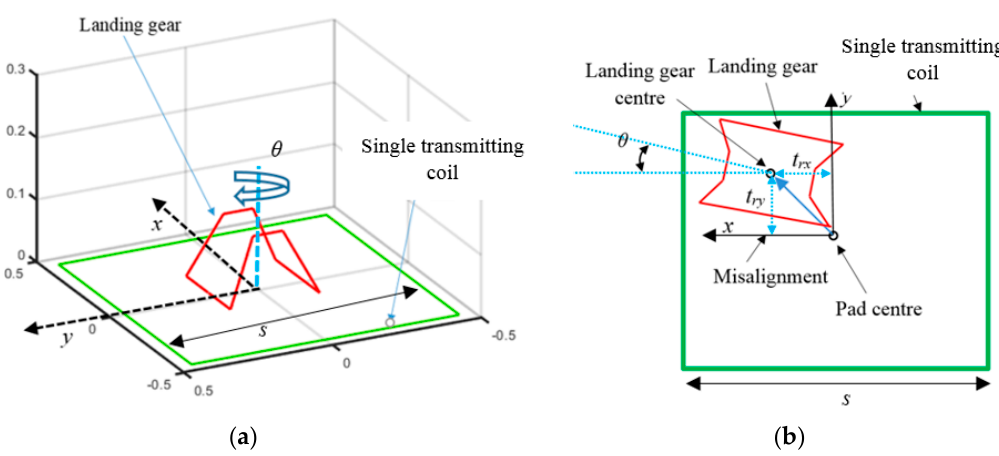
Figure 4. Coil configuration with a single transmitting coil (in green) and a 3D receiving coil (in red) ( a ). Top view of the coil configuration with lateral offsets t rx , t ry and rotation θ of the receiving coil ( b ).